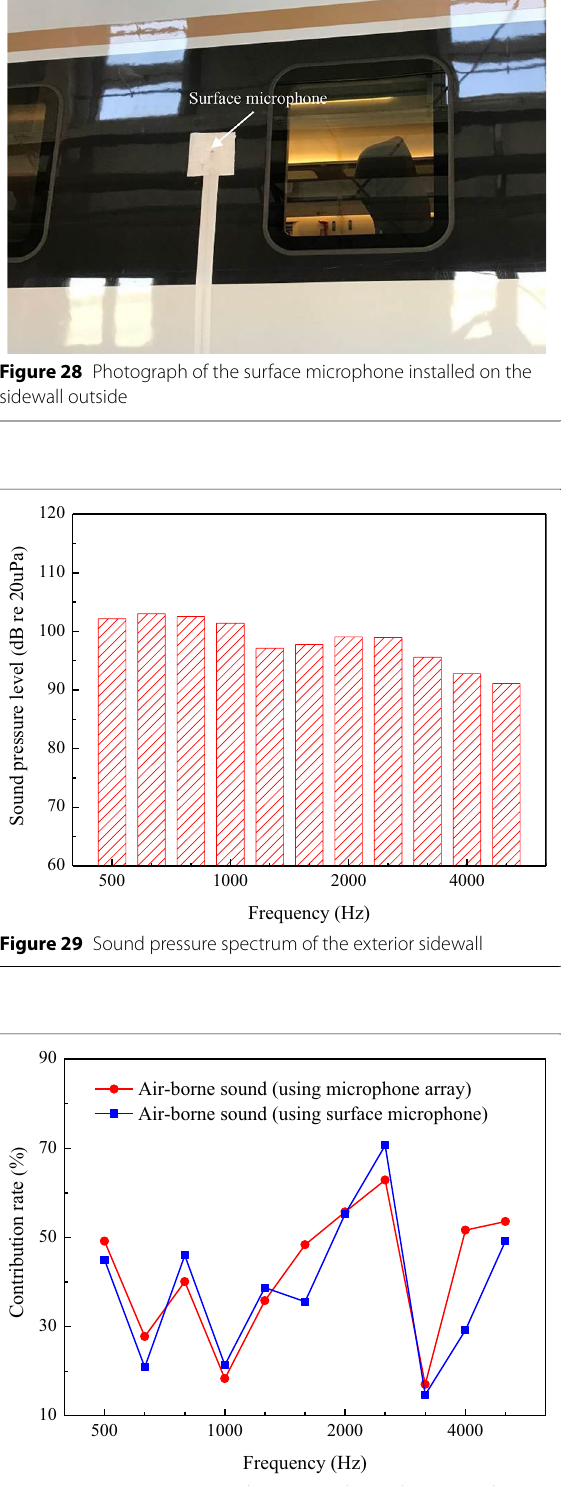
Figure 30 A comparison in airborne sound contribution results between using microphone array and using surface